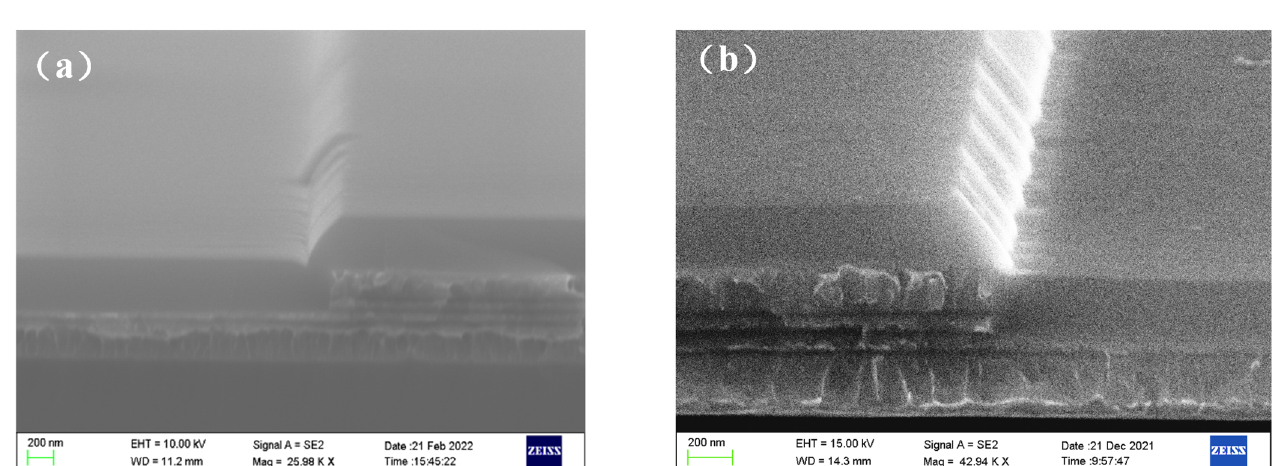
Figure 3. SEM images of the step coverage profiles for RF powers of ( a ) 100 W and ( b ) 200 W. The ICP power was set at 800 W, and the deposition pressure was set at 4 mTorr. ICP power was set at 800 W, and the deposition pressure was set at 4